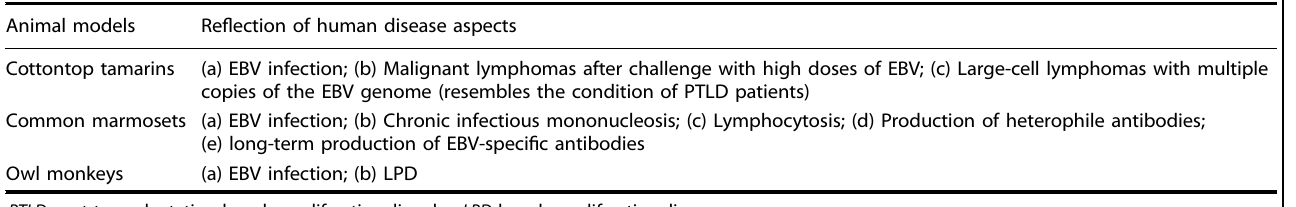
Table 3. Outcomes of Nonhuman primate after EBV infection re fl ect different aspects of human diseases. Animal